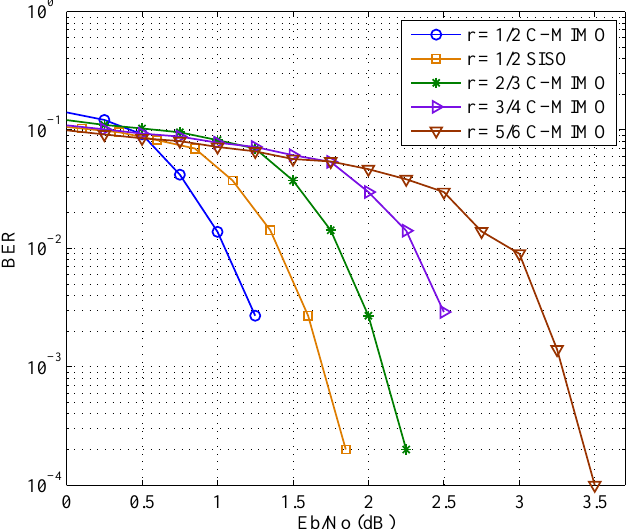
Figure 9. Bit error rate over SNR curve for different encoding